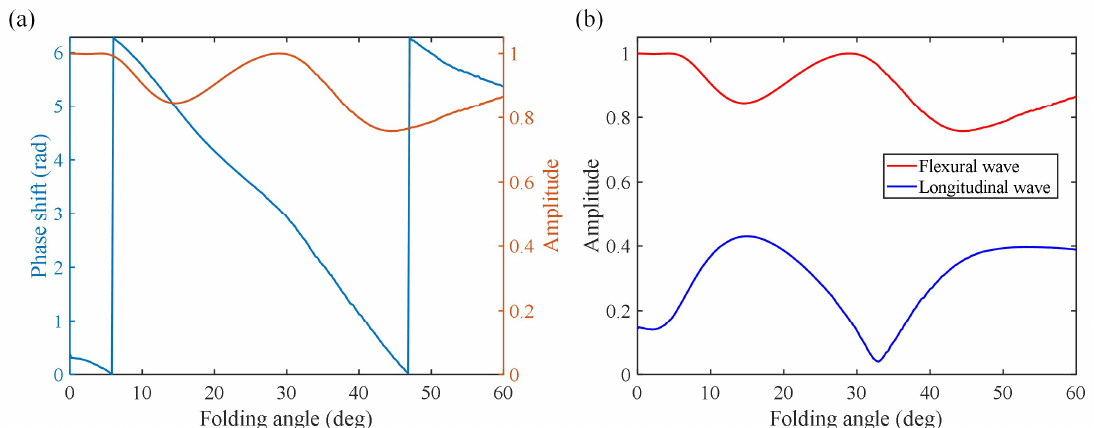
Figure 2. ( a ) Phase shift and amplitude of the reflected flexural wave and ( b ) amplitude of the reflected flexural wave and reflected longitudinal wave for the zig-zag structures with different folding angles at 8000 Hz obtained from the numerical simulations.